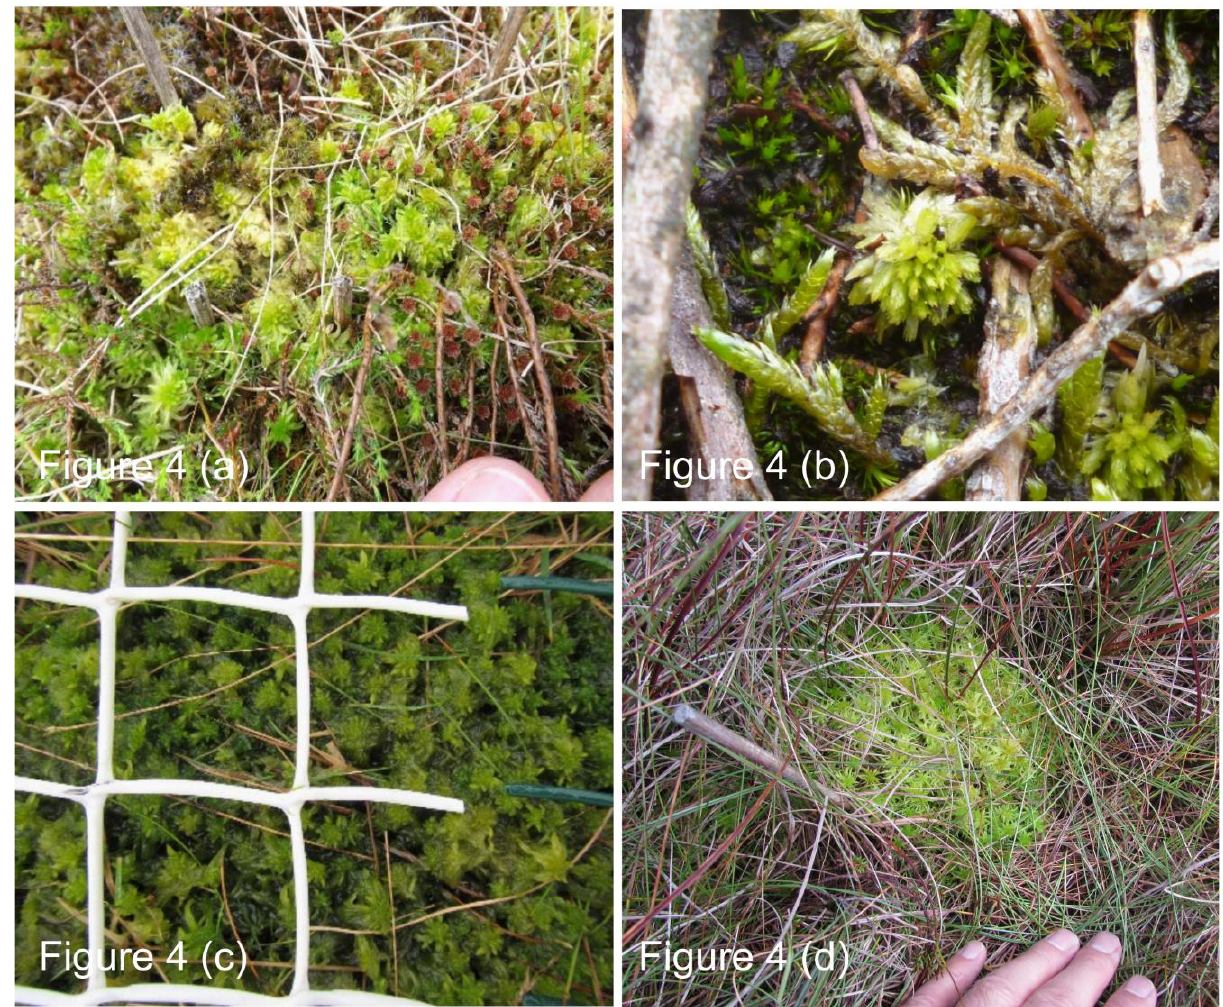
Figure 4. S. fallax growth from beads after application to various degraded peat surfaces on blanket bog: (a) dense growth on treated surface (lime, fertiliser and grass seed) with brash cover; (b) poor establishment on untreated bare peat with brash cover; (c) vigorous growth on treated (lime, fertiliser and grass seed) peat pan; (d) healthy Sphagnum colony arising from one or more beads in E. angustifolium dominated intact peatland with water table consistently close to the peat surface. All photographs were taken more than six years after the planting date (a and b: Trial A; c and d: Trial